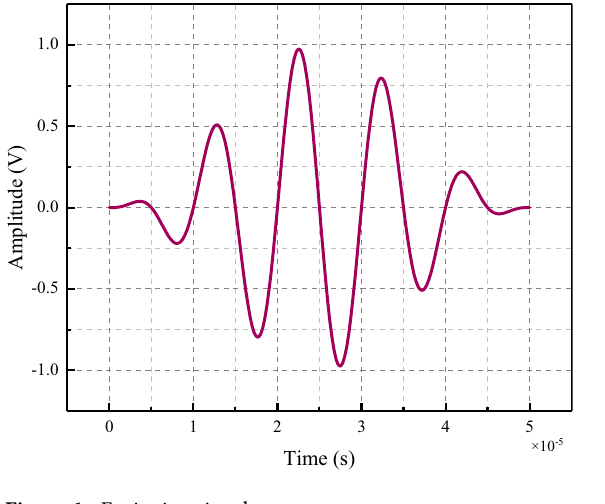
Figure 6. Excitation